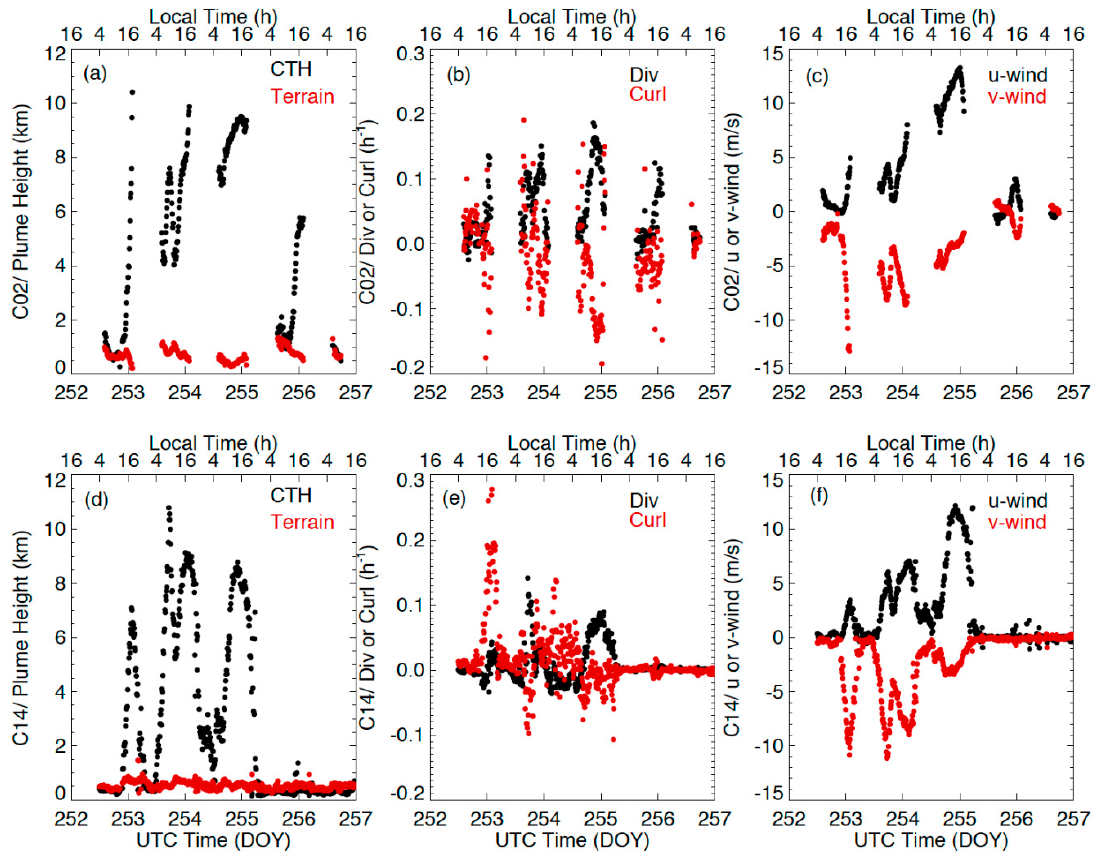
Figure 22. Time series of area-mean ( a ) plume height (CTH) above terrain, ( b ) divergence (black) and curl (red), and ( c ) u-(black) and v-wind (red) variations during 8–12 September (DOY 252–256). Area-averaged terrain heights (red) are also included in ( a ) and vary slightly with time because it is averaged only for the site locations where an acceptable quality stereo height is reported. Panels ( d – f ) report the same information but for Band 14.